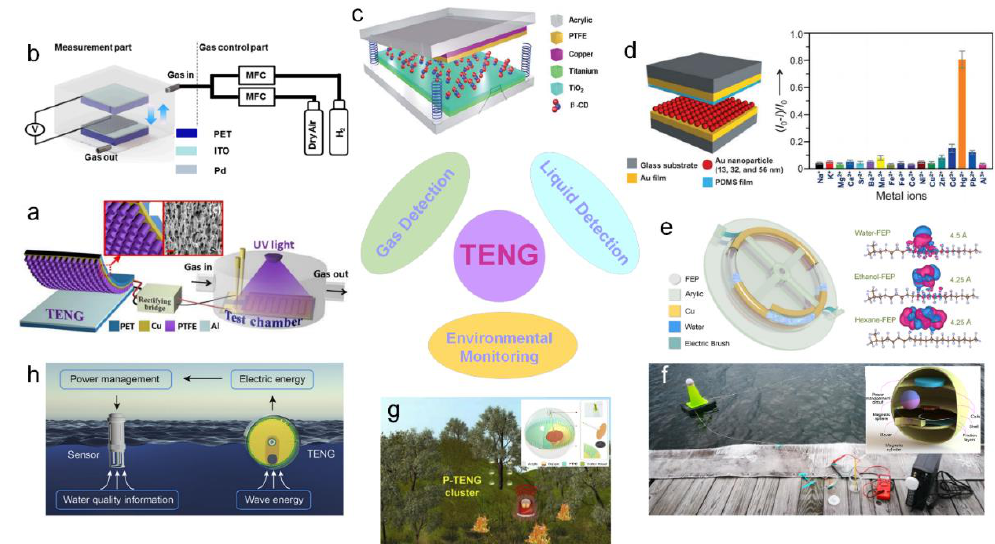
Figure 17. TENGs for gas and liquid detection and environmental monitoring. ( a ) Self-powered room